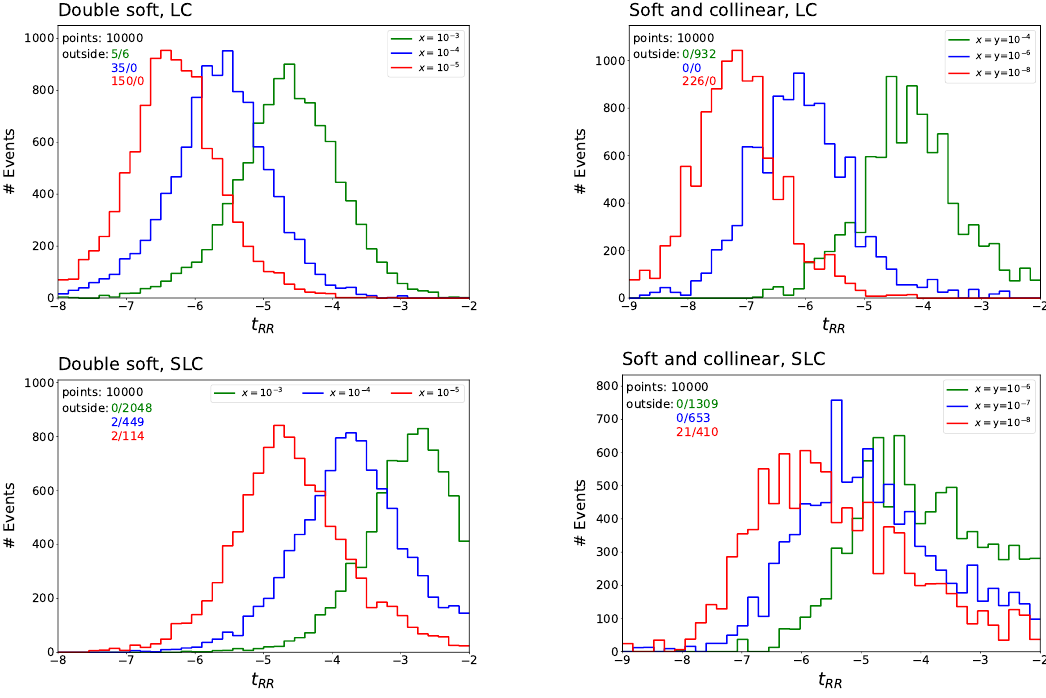
Figure 3 . Test of the double real subtraction term in double soft (left) and soft and collinear (right) limits for the leading colour (upper plots) and subleading colour (lower plots)